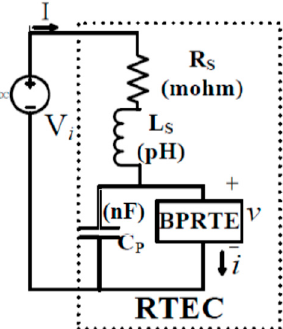
Figure 3. Single PVCDR RTEC unit with C p , R S and L S values [1].